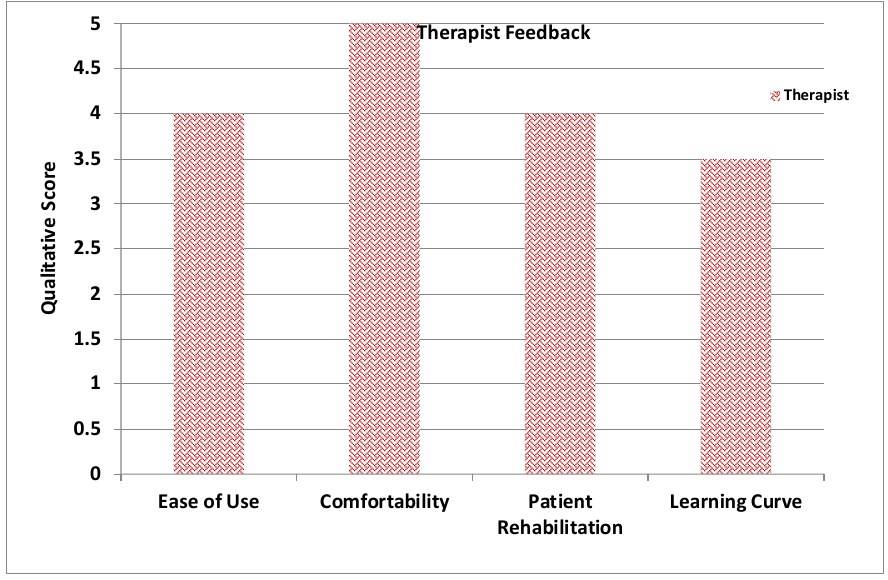
Figure 18. Average therapists’ feedback.